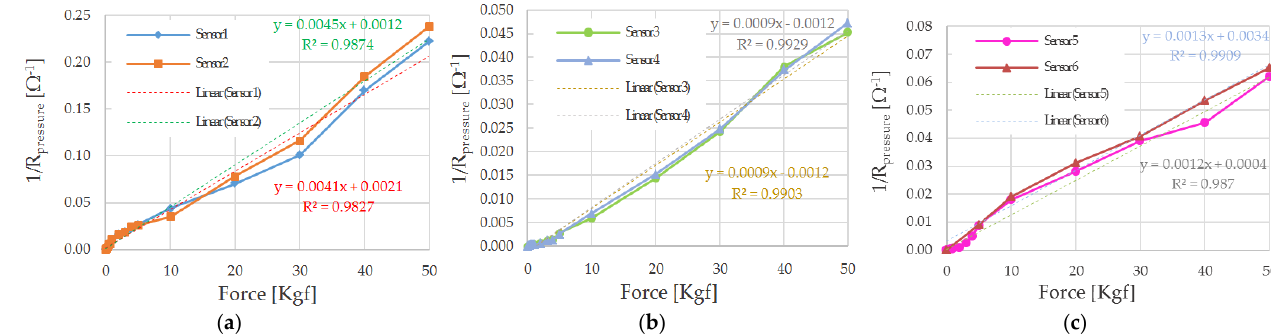
Figure 29. Trends of the reciprocal of sensor resistance as a function of the applied force (expressed in Kgf) for sensors 1 and 2 (3 cm × 3 cm) ( a ), sensor 3 and 4 (1 cm × 1 cm) ( b ), and sensor 5 and 6 (3 cm × 1 cm) ( c ).